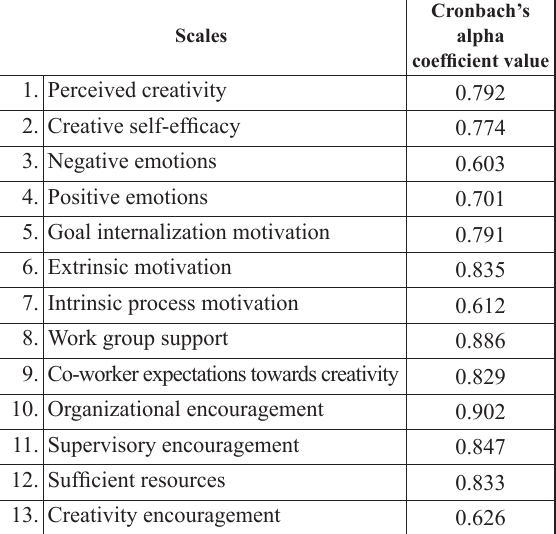
Table 1. Chronbach’s alpha coefficients of the scales used in the